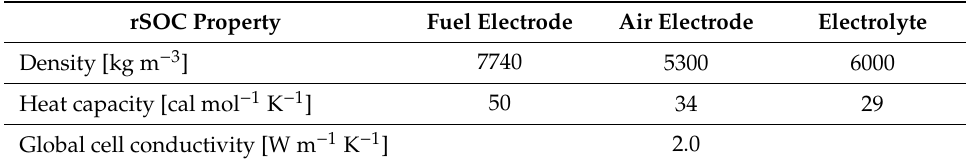
Table 5. Main parameters for the thermal behavior of a rSOC short